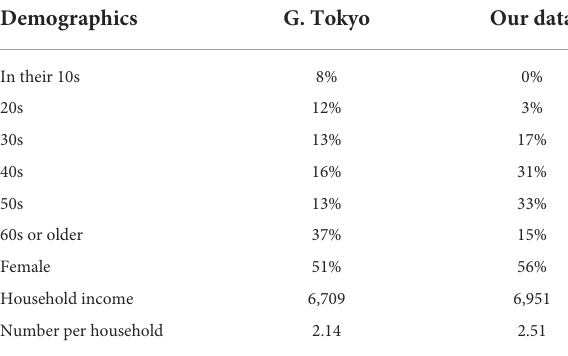
TABLE 1 Comparison between official demographics of metropolitan areas and home scan